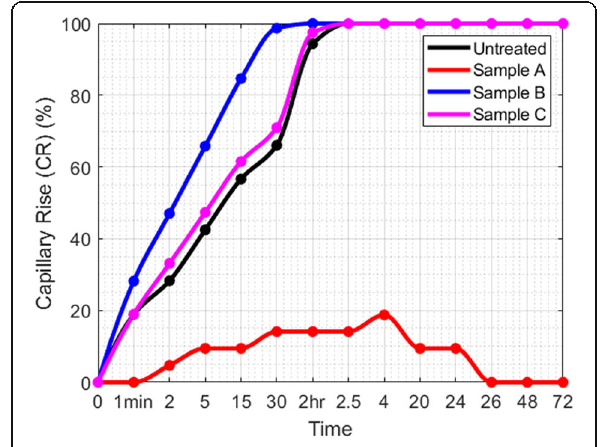
Fig. 4 Capillary Rise of Compacted Samples Fig. 5 Comparison of the untreated sample and the treated